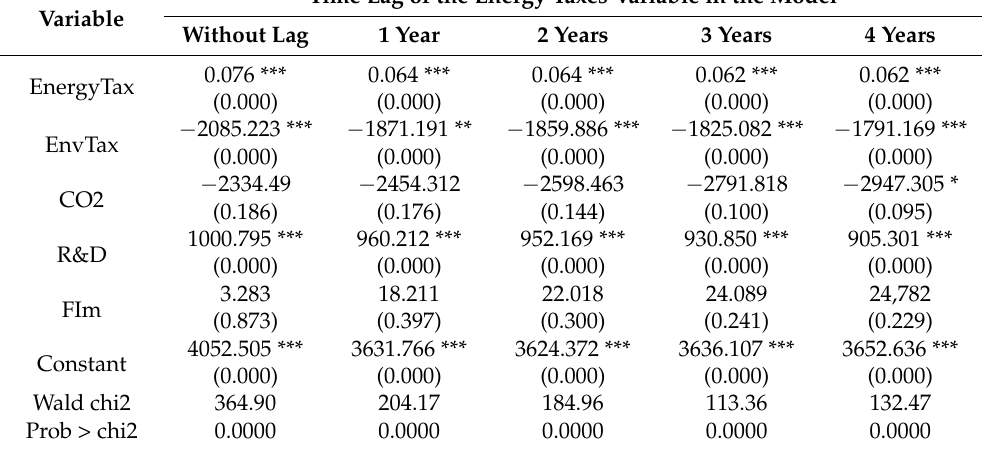
Table 5. Results of the assessment of energy taxes impact on the biofuel consumption in the European countries for